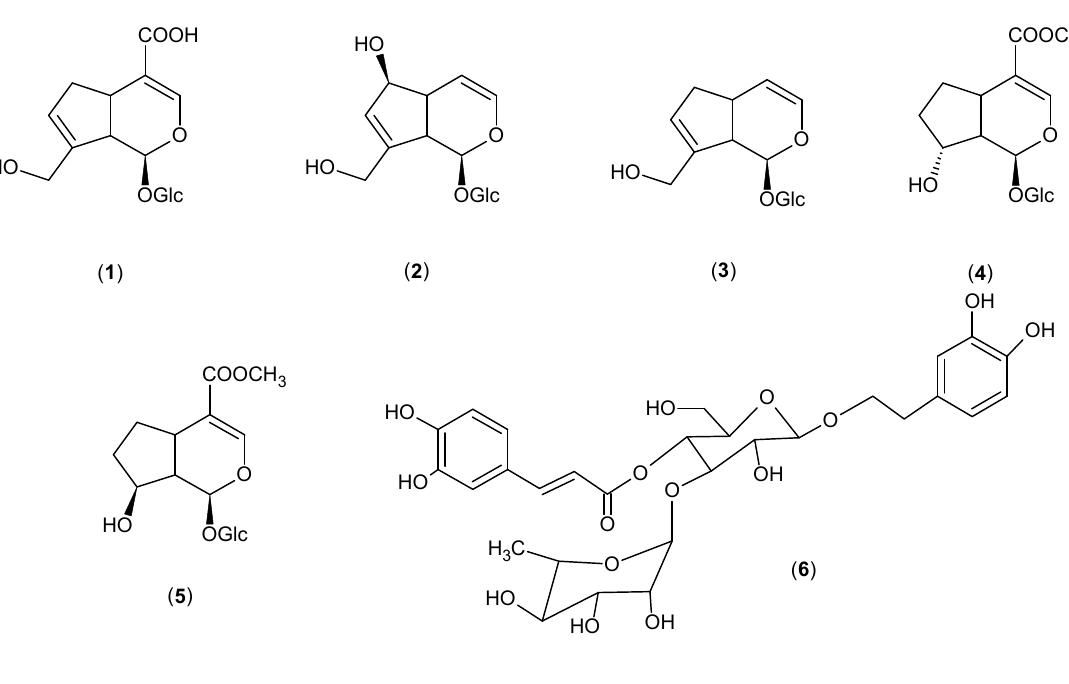
Figure 2. Chemical structures of the compounds isolated from Castilleja